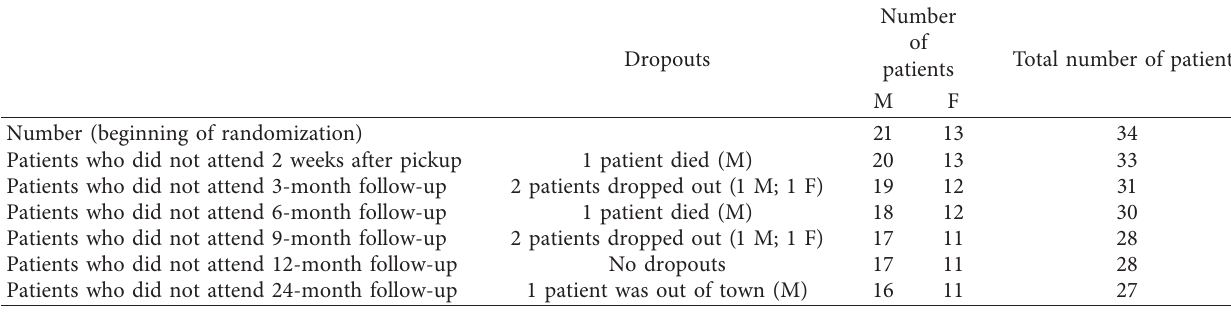
Table 2: Number of patients after randomization into the ball attachment